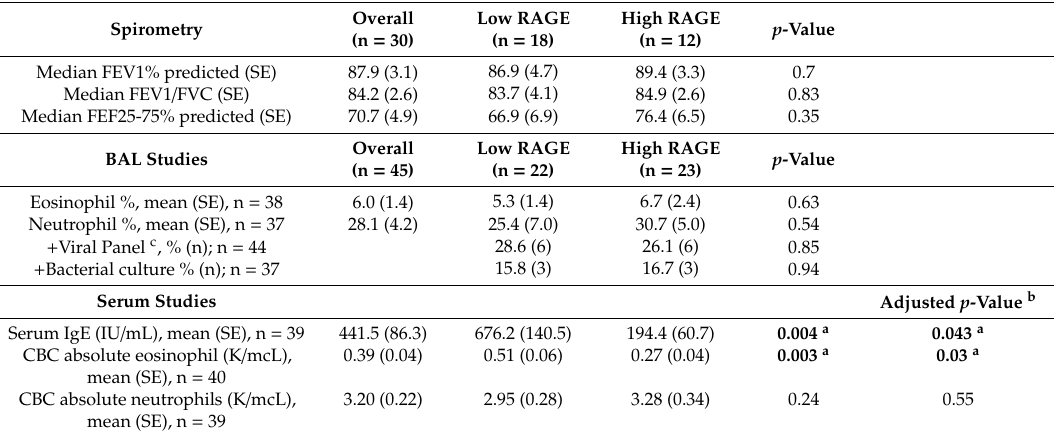
Table 2. Patient